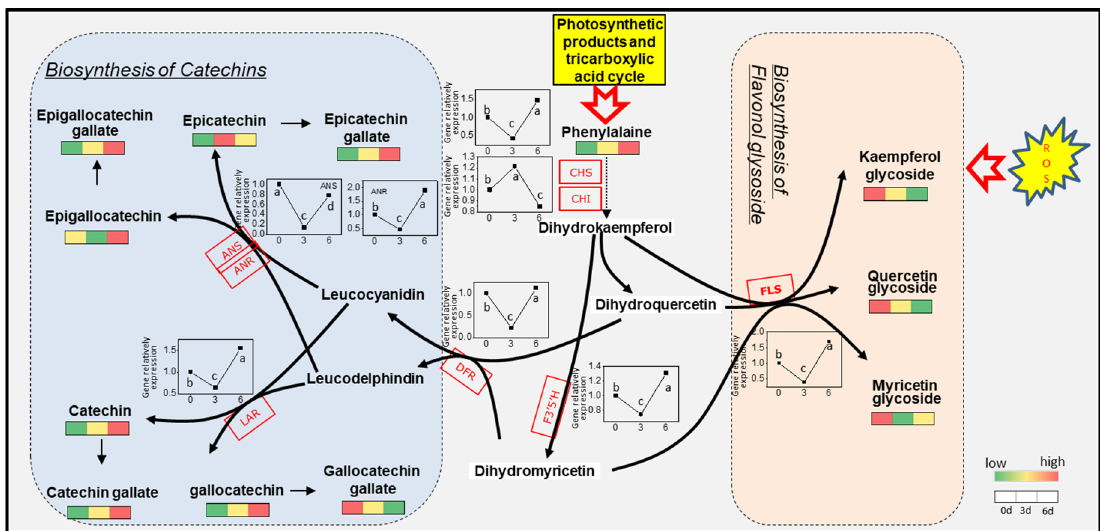
Figure 6. Schematic presentation of phenylpropanoid/flavonoid pathway in albino tea leaves of ‘Baiye 1 (cid:48) . ANS, anthocyanidin synthase; ANR, anthocyanidin reductase; LAR, leucoanthocyanidin reduc-tase; DFR, dihydroflavonol-4-reductase; CHS, chalcone synthase; CHI, chalcone isomerase; FLS, flavonol synthase; F3 (cid:48) 5 (cid:48) H, flavonoid-3 (cid:48) , 5 (cid:48) -hydroxylase ( n = 3). Different letters (a, b, c, d) above the bars indicate significant ( p < 0.01) differences among the three shading